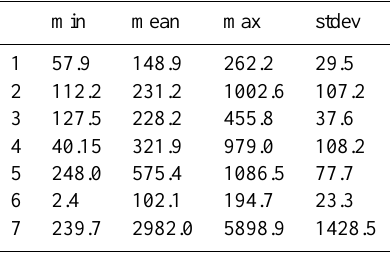
Table 1. Data summary: minimum (min), mean, maximum (max), and standard deviation